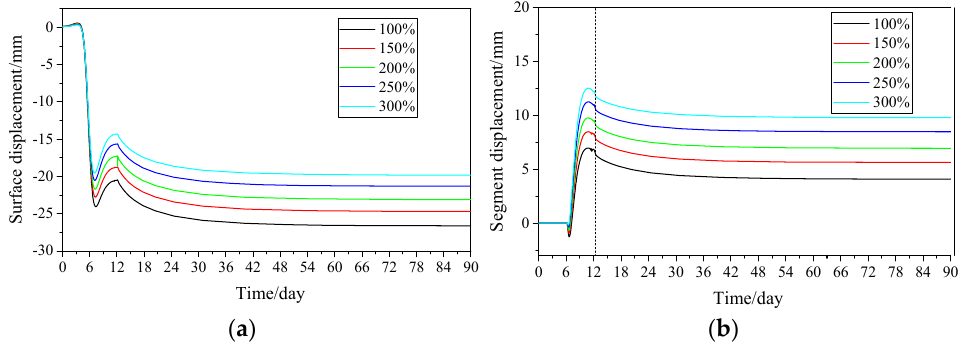
Figure 10. Displacement of surface and tunnel under different grouting filling rate. ( a ) Development of surface displacement with time; ( b ) Development of segment displacement with time.